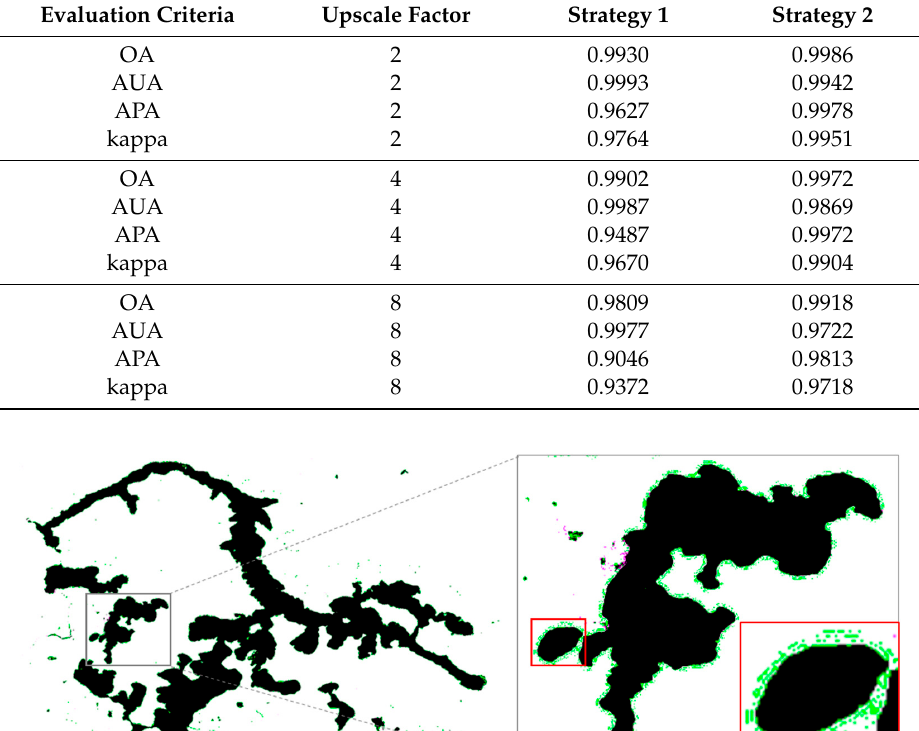
Table 3. Detailed results of two strategies on different upscale factors.